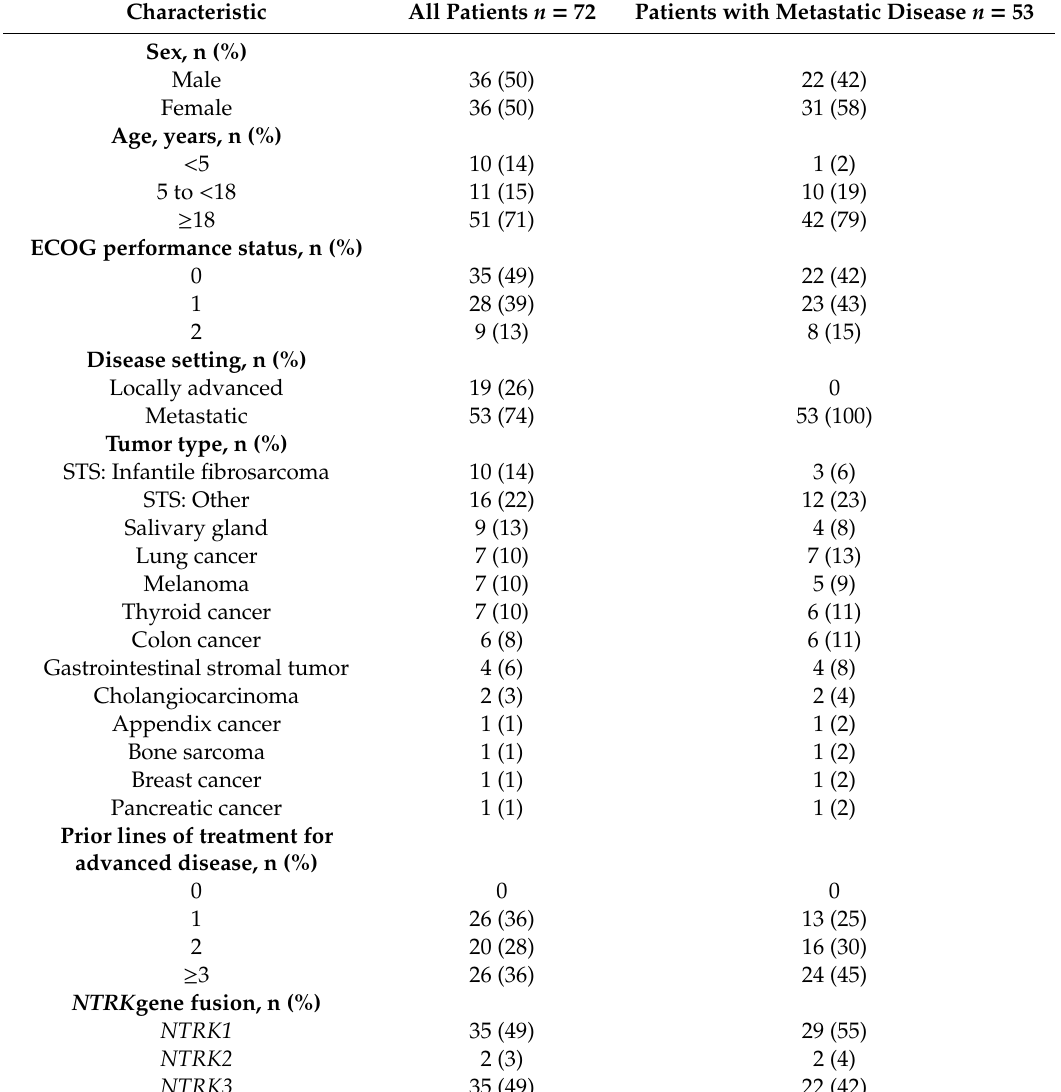
Table 1. Patient baseline